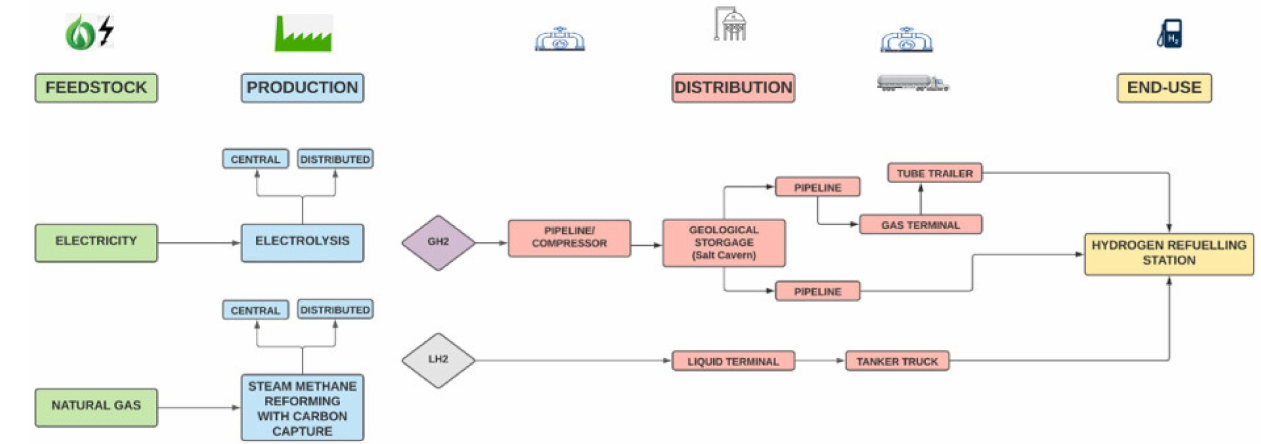
Figure 1. Supply chain network for analyzing cost of dispensed hydrogen at the station based on the